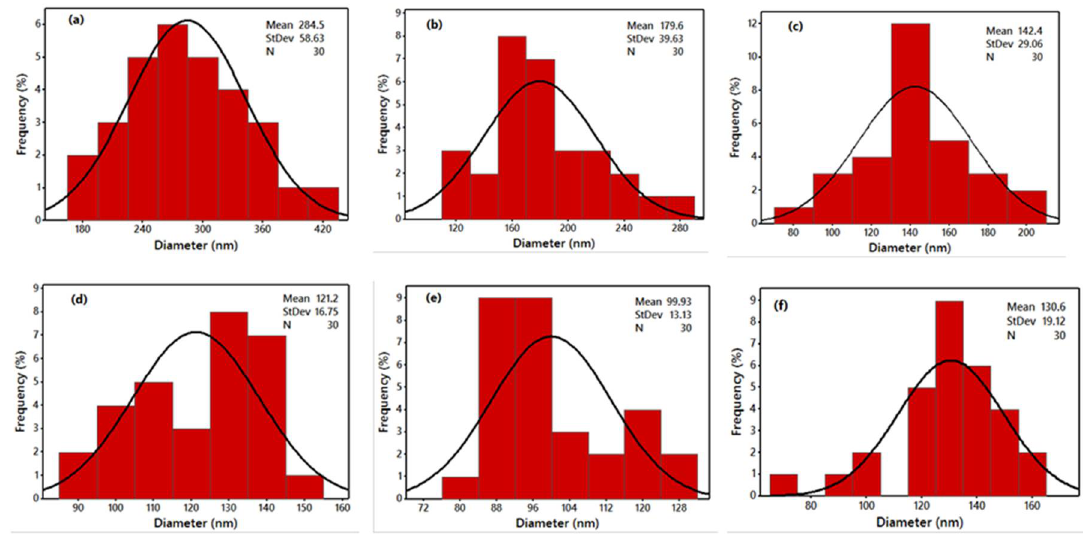
Figure 3. Diameter distribution histograms of W S CHT/PVA nanofibers; ( a ) 10:90, ( b ) 15:85, ( c ) 20:80, ( d ) 25:75, ( e ) 30:70, and ( f ) Crosslinking of CR ( c ) 20:80.